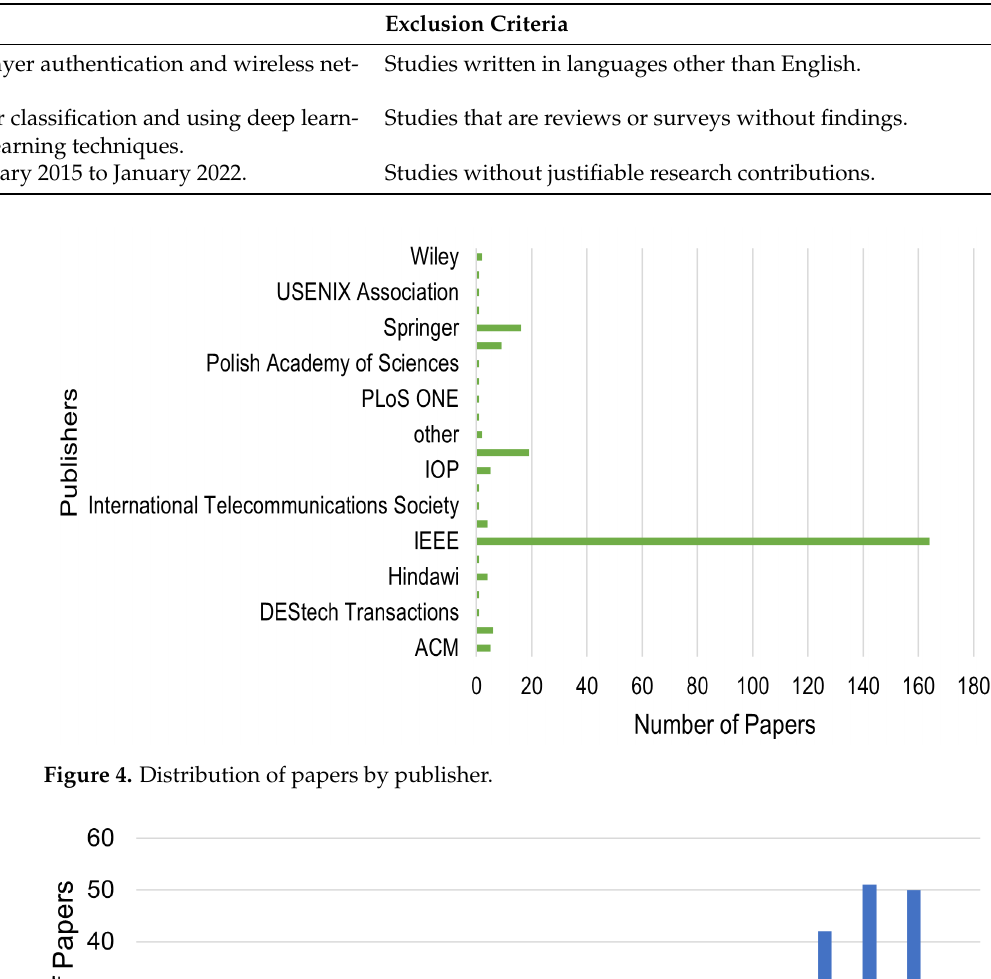
Table 3. Inclusion and exclusion criteria to select the primary studies.